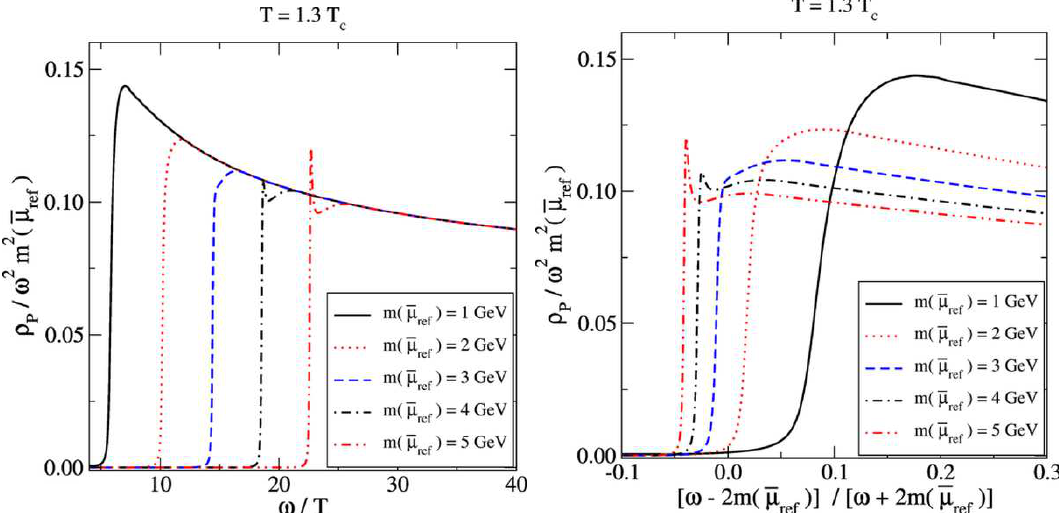
Figure 1 . Spectral functions interpolating between a thermal contribution around the threshold (section 4) and MS asymptotics above the threshold (eq. (3.10)). The normalization of the near- threshold contribution (cf. eq. (4.10)) and the matching point have been treated as free parameters; we find A 1 . 2 . . . 1 . 3 and ω 2 . 3 . . . 2 . 6 M . The other parameters correspond to table 1, match ≈ ≈ with M M x =6 ≡